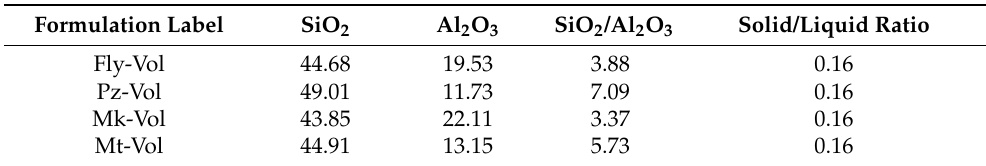
Table 2. Geopolymer paste composition, based on volcanic ash with fly ash, pozzolan, metakaolin, and mining